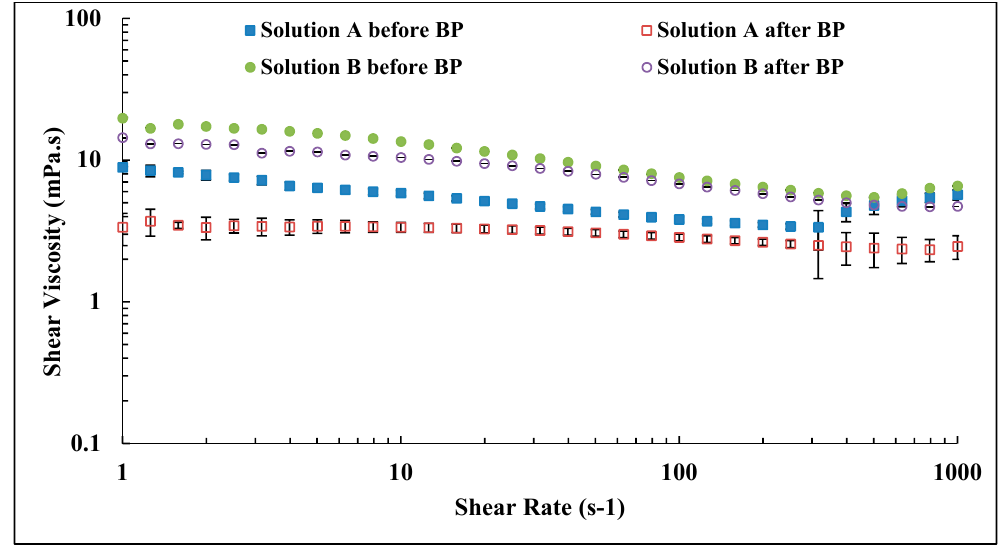
Figure 7. Shear viscosity vs. shear rate of polymers injected through backpressure regulator at high flow rates. Table 3. Effect of backpressure regulator on shear viscosity of Solutions A and B. Shear viscosity measured at γ(cid:4662) = 10 s (cid:2879)(cid:2869) . Measurements